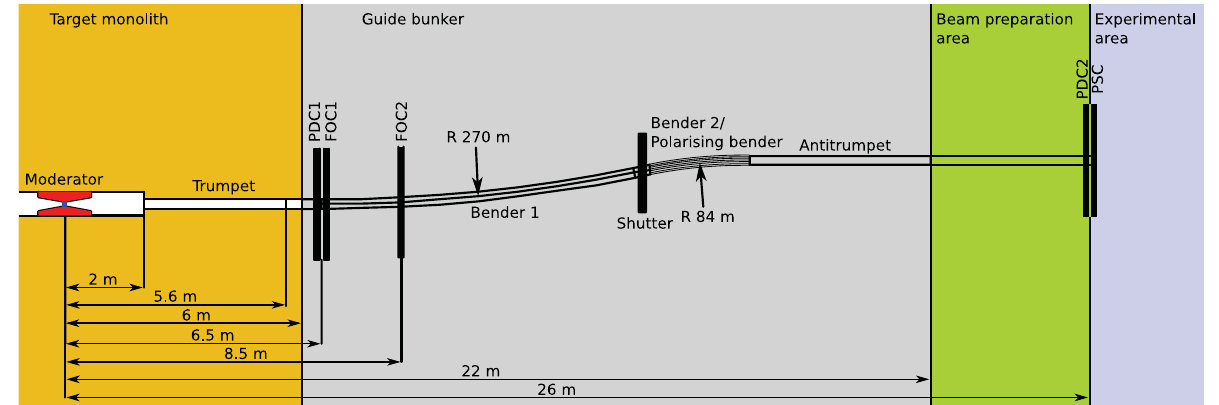
Figure 1. Side view of the ANNI beam line (schematic). The vertical scale is stretched by a factor of 4 for better readability. See text and Tables 1 and 2 for details.